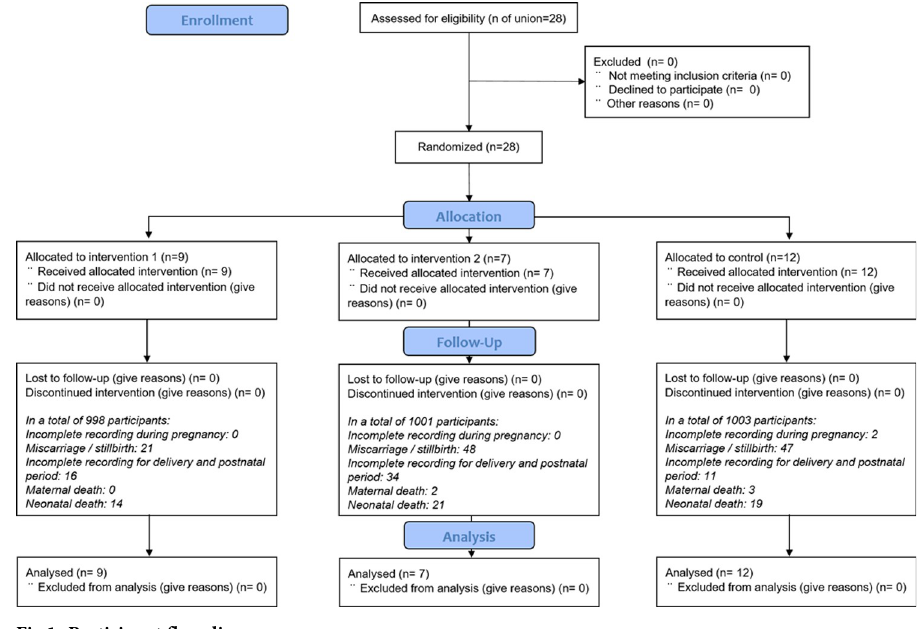
Fig 1. Participant flow